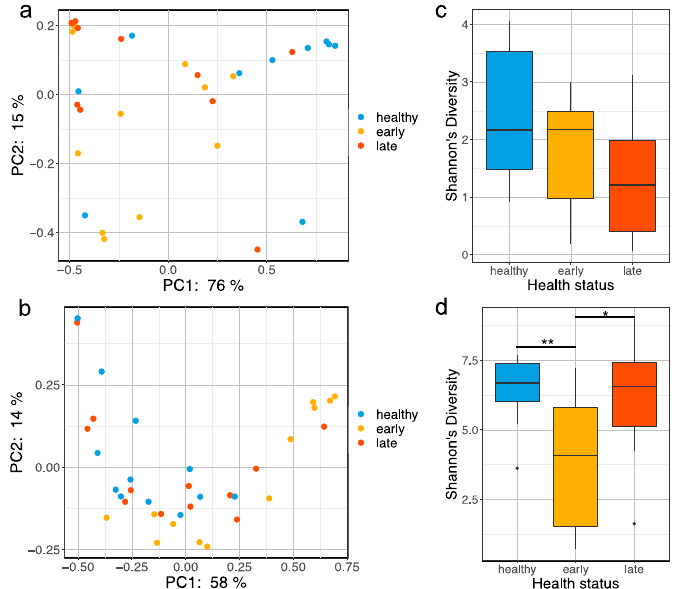
Figure 1. Global bacterial community changes associated with gut enteritis. PCoA plot based on the weighted Unifrac distance matrix showing clustering of gut ( a ) and skin ( b ) microbiota samples by health status (e.g., healthy, early stage of enteritis and late stage of enteritis); boxplot representing the Shannon’s diversity of the gut ( c ) and skin ( d ) microbiota for the di ff erent health status. Statistical di ff erences were assessed using a Kruskall–Wallis test, with the levels of statistical significance between groups denoted by asterisks, with alpha set at